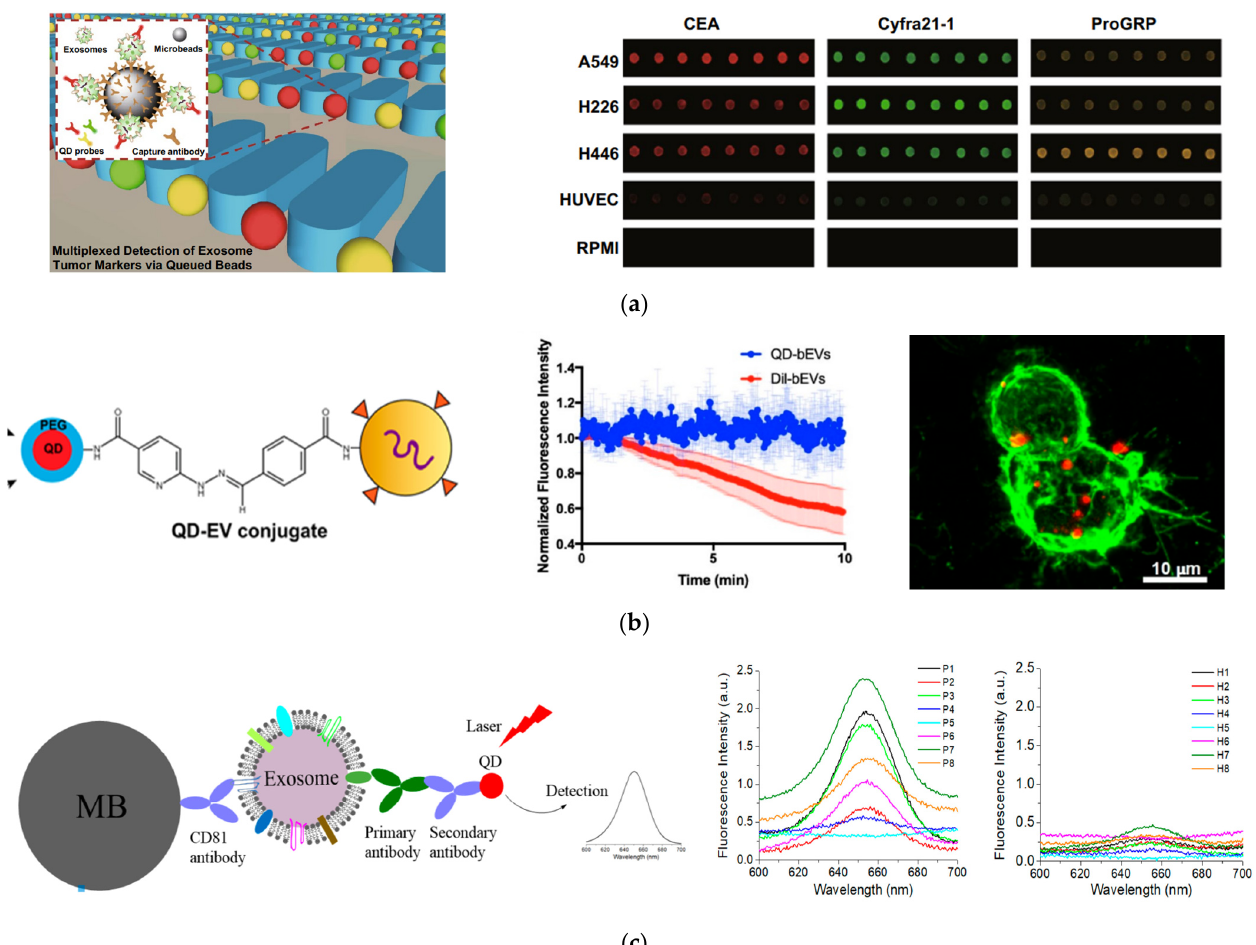
Figure 5. Fluorescent detection of exosomes using QDs. ( a ) Isolation and multiplexed detection of exosomal tumor markers using QDs and magnetic beads in a microarray chip. Left: Schematic of the methodology showing exosome isolation with single magnetic bead trapped in the microfluidic pillars and multiplexed detection with multicolor QDs. Right: Fluorescence images of exosomes derived from different cell lines using three different target-specific QDs: QD525, QD585, and QD625. Cited from ref. [115]. ( b ) EV labeling and visualization with QDs. Left: Schematic of EV labeling with QDs. Middle: Photostability of QDs in comparison to Dil dye. Right: Fluorescence imaging showing the distribution of QD-labeled EVs (red) on lection stained BV-2 cells (green). Reprinted with permission from [117]. Copyright (2020) American Chemical Society. ( c ) Detection of breast cancer with QDs combined with immunomagnetic separation. Left: Schematic of the immunomagnetic isolation with magnetic beads and fluorescence detection of surface protein markers by QD655. Right: Fluorescence spectrum of exosomes from HER2-positive breast cancer patients and healthy donors after labeling with HER2-targeted QDs showing diagnosis potential of QDs for detection of HER2-positive breast cancer. Cited from ref. [119].